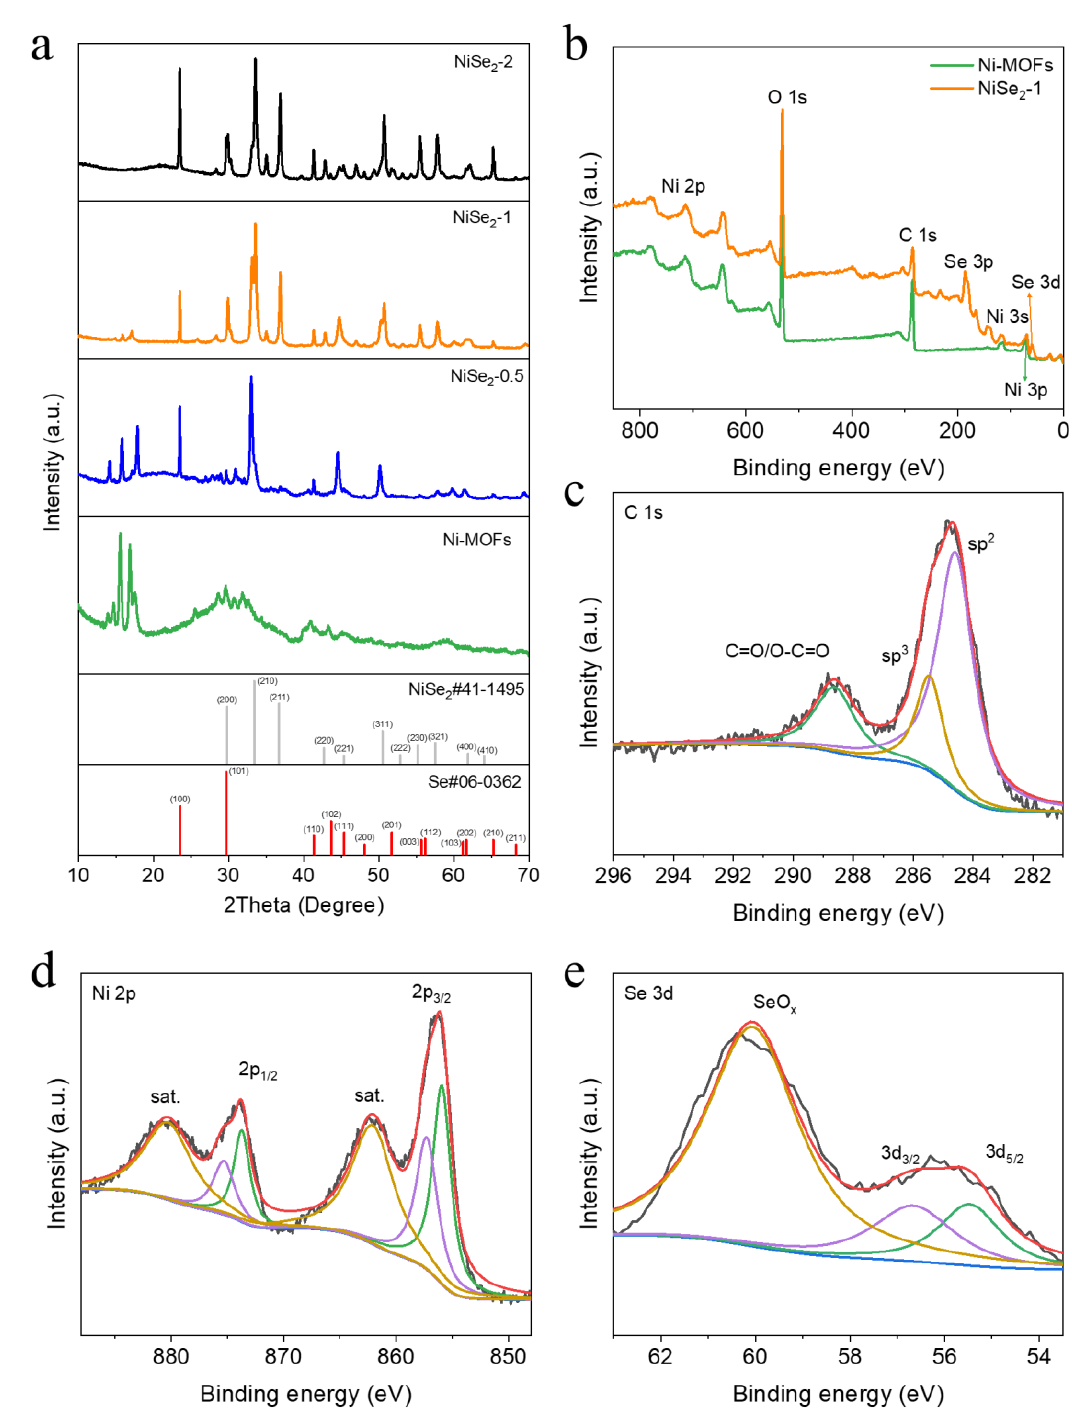
Figure 2. ( a ) XRD patterns of Ni-MOFs and NiSe 2 − X (X = 0.5, 1, 2). ( b ) XPS survey of the Ni-MOFs and NiSe 2 − 1 samples. ( c ) High resolution XPS spectra of C 1s. ( d ) Ni 2p and ( e ) Se 3d XPS spectra.